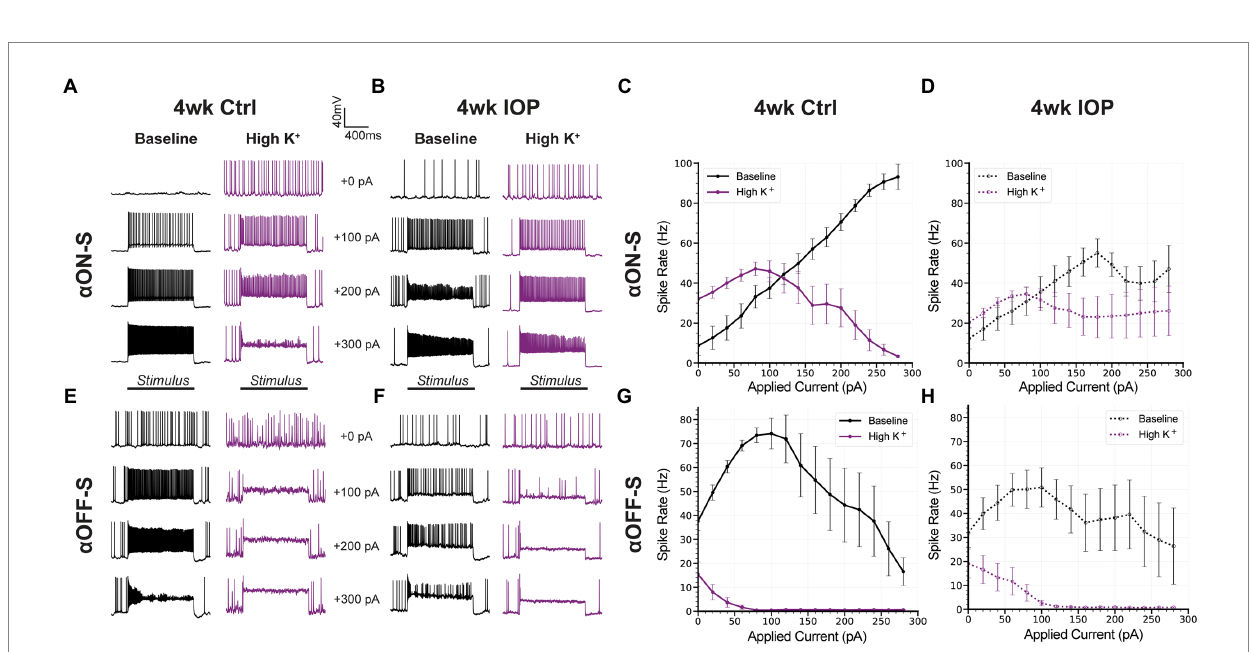
FIGURE 4 Current-evoked spiking is less depressed by high K + after IOP elevation. (A,B) Representative current-clamp responses of α ON-S cells from both experimental groups to 0, 100, 200, and 300 pA pulses, before and after washing on high K + . (C,D) The spiking responses of α ON-S cells to depolarizing current pulses ranging from 0 to 300 pA, before and after high K + . (E,F) Representative current-clamp responses of α OFF-S cells from both experimental groups before and after washing on high K + . (G,H) The spiking responses of α ON-S cells to depolarizing current pulses, before and after high K + . The difference in spike rates between baseline and high K + groups for all cells is lower in the 4wk IOP group than in the 4wk Ctrl ( p = 0.0317, unpaired t -test). Error bars: ± standard error of the